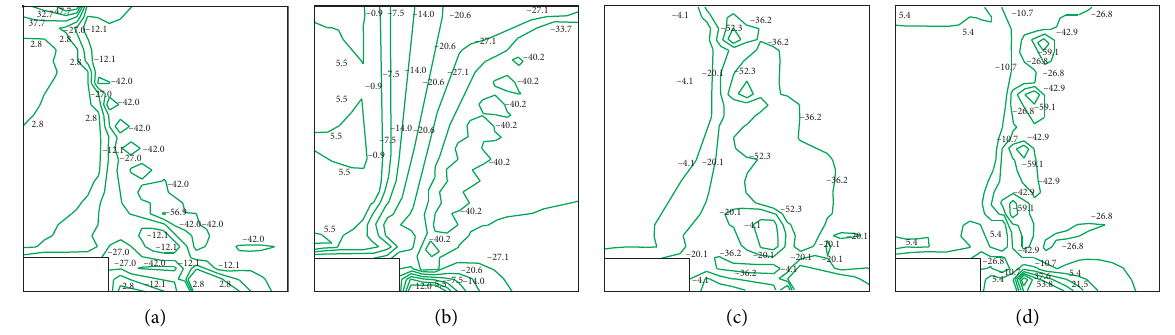
Figure 9: Max principal stress (kPa). (a) Hard-Soft. (b) Soft-Hard. (c) Soft-Soft. (d) Hard-Hard.